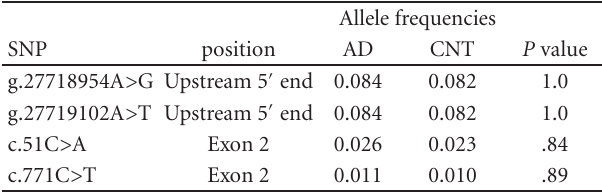
Table 1: Demographic, clinical, and genetic characteristics of pa- tients with AD and controls.